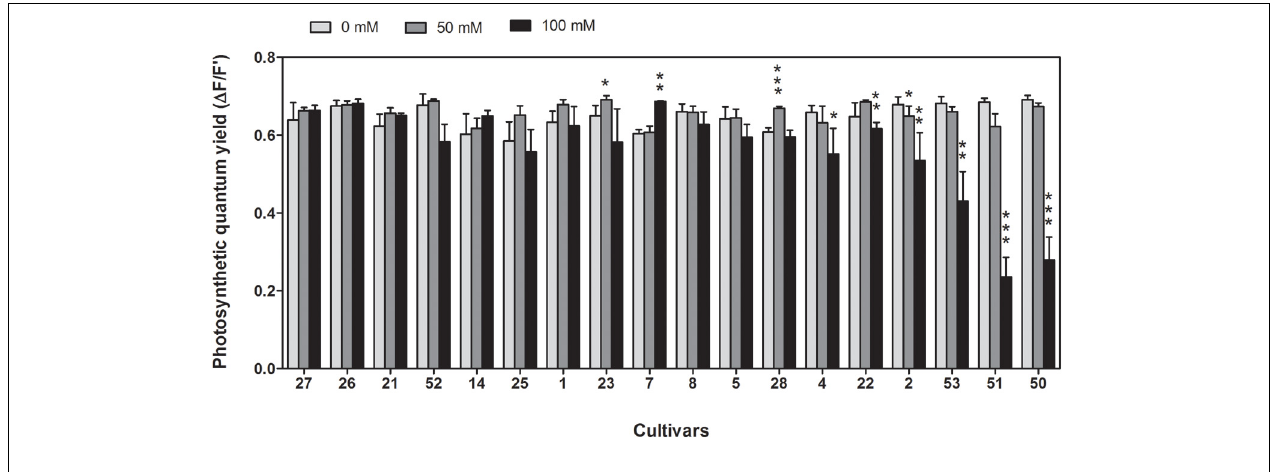
FIGURE 2 | Photosynthetic quantum yield of 18 rice cultivars under control conditions and after 13 days at 50mM or 100mM NaCl in hydroponic culture. Means of three independent experiments with five replicate plants each are shown with